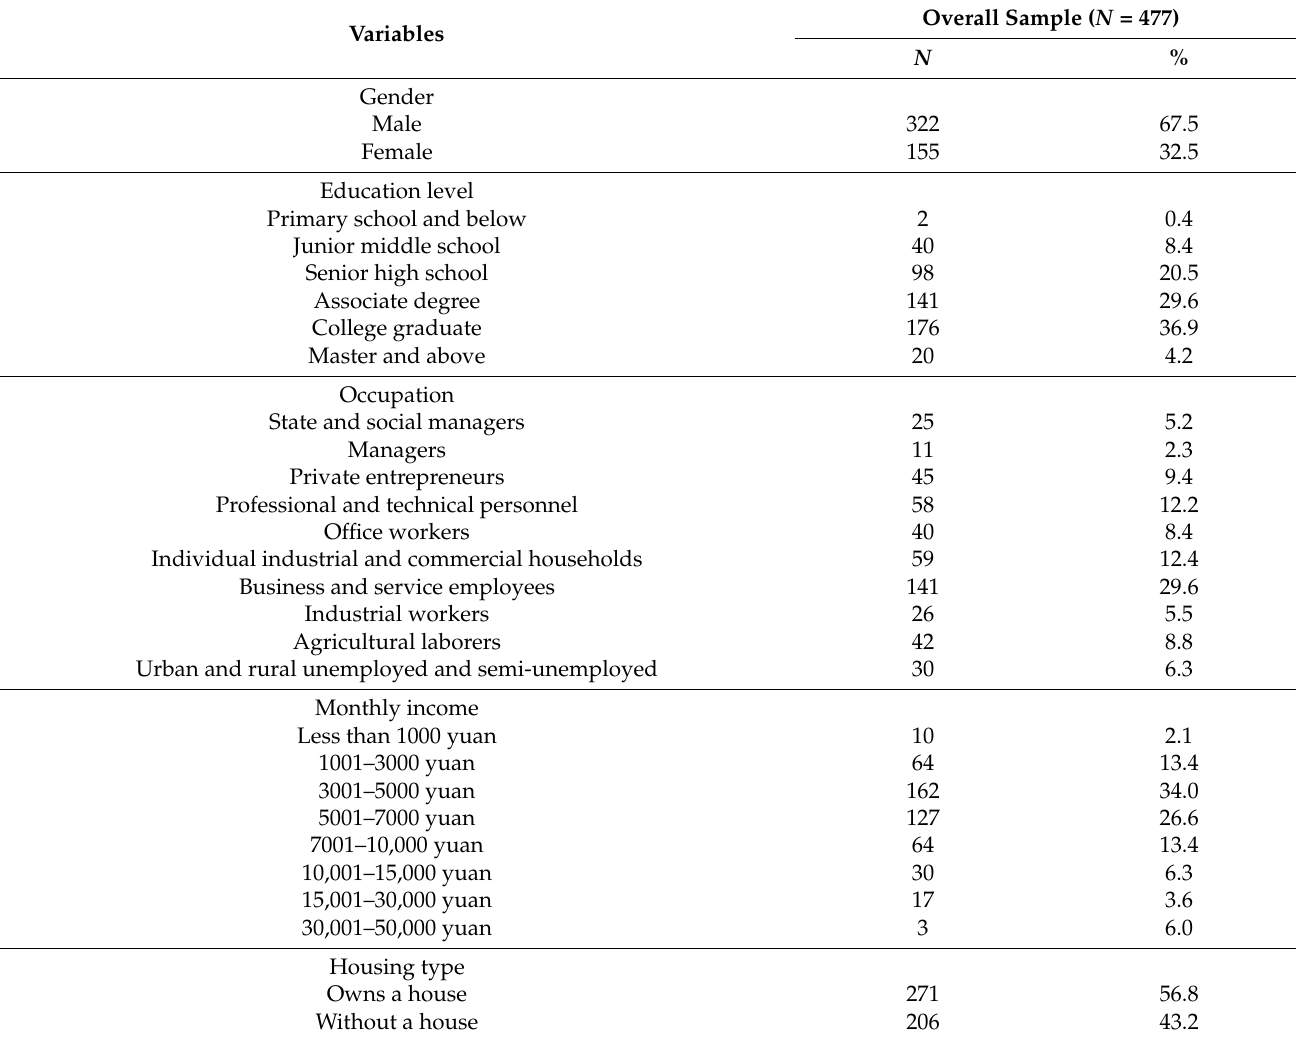
Table 1. Demographic characteristics of the